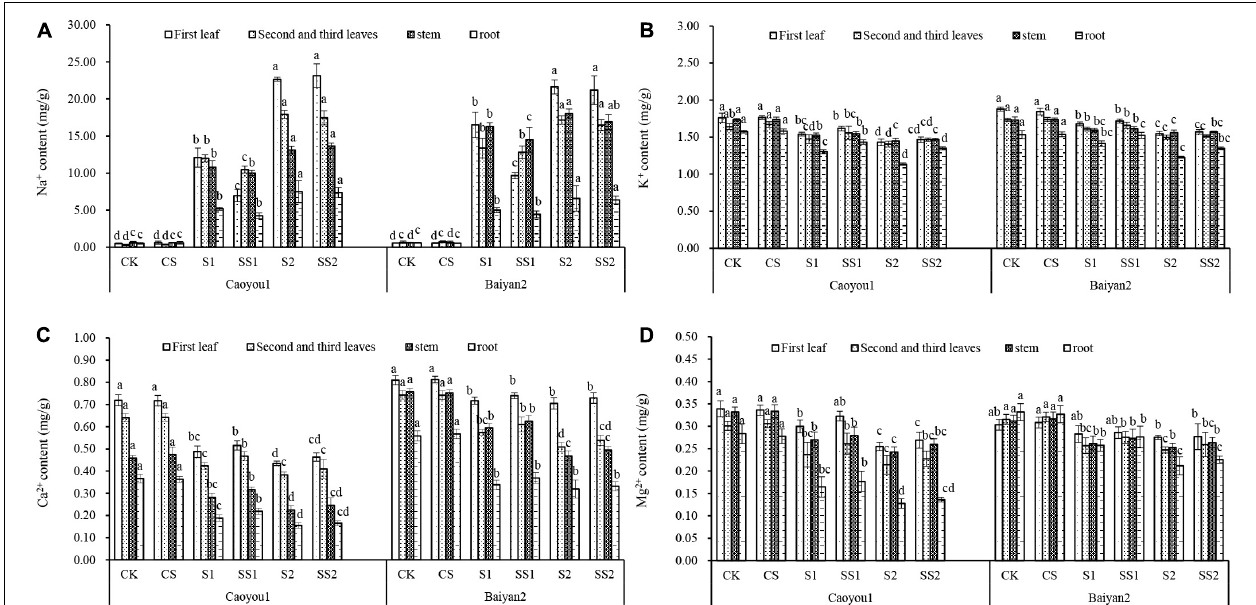
FIGURE 8 | Effects of Spd application on Na + (A) , K + (B) , Ca 2 + (C) , and Mg 2 + content (D) under salt stress in the oat seedlings. CK, Nutrient solution + distilled water; CS, Nutrient solution + 0.75 mM Spd; S1, 70 mM salt + distilled water; SS1, 70 mM salt + 0.75 mmol/L Spd; S2, 100 mM salt + distilled water; SS2, 100 mM salt + 0.75 mmol/L Spd; Different lowercase letters indicate significant differences between treatments at 0.05